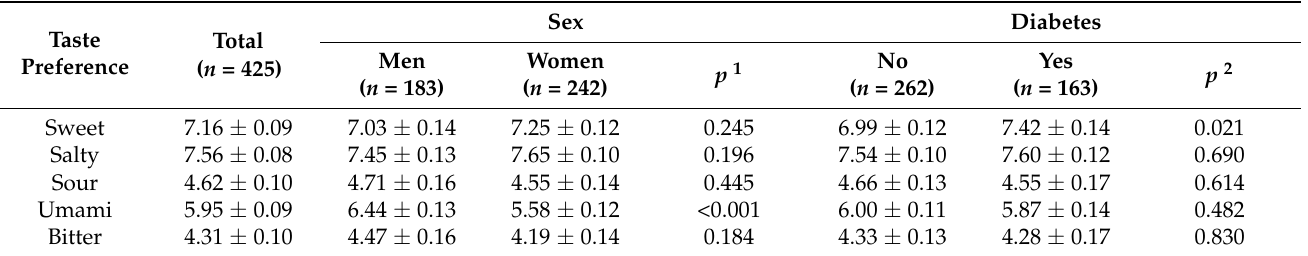
Table 2. Taste preferences (sweet, salty, sour, umami and bitter) in the whole population and stratified by sex and type 2